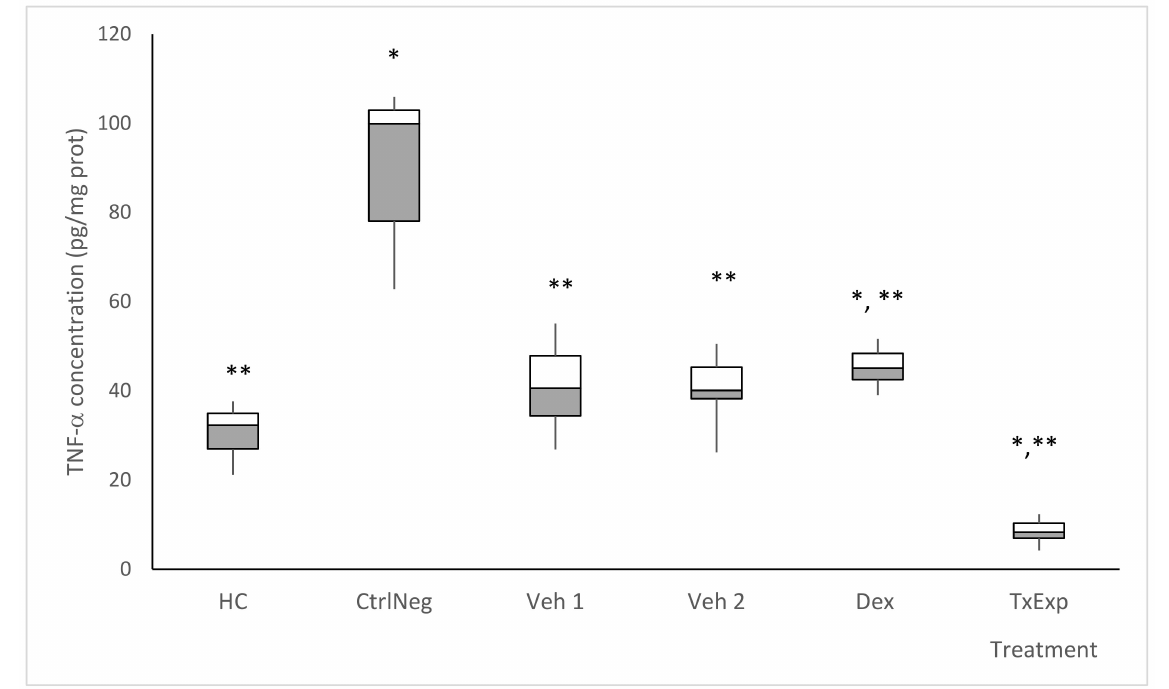
Figure 8. Tissue concentration of Tumor Necrosis Factor α (TNF- α ). The treatment groups correspond to the mice without any treatment (HC). The negative control group was administered with TPA. The Veh1 and Veh2 control groups correspond to the TPA dissolution vehicle (acetone) and the treatment dissolution vehicle (cyclodextrin and Tween 20). The positive control received TPA and dexamethasone (0.5%). S. dendroideum extract is the experimental treatment. Post hoc Tukey ANOVA n = 6, (**) p < 0.05, with respect to the negative control group and (*) p < 0.05 with respect to the healthy control group (n =